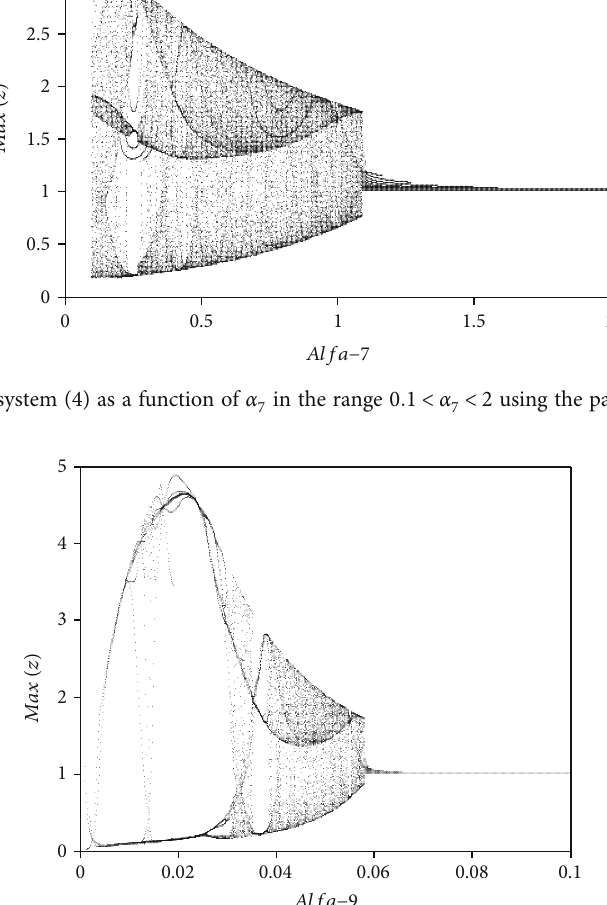
Figure 14: The BD of system (4) as a function of α